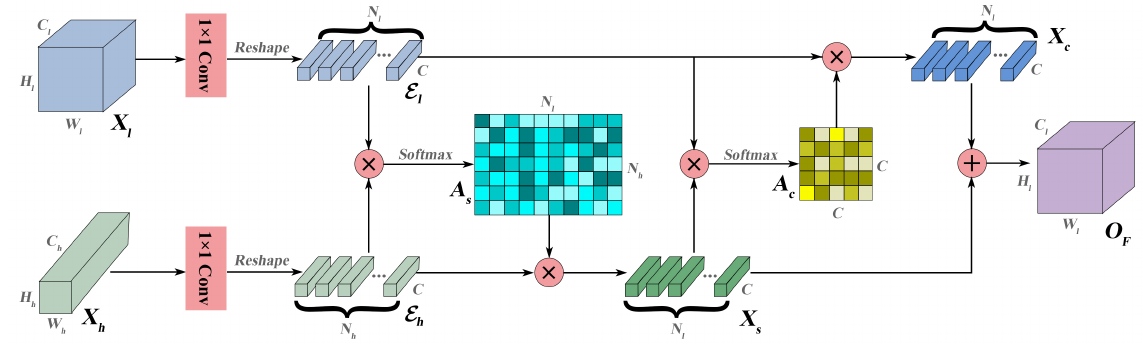
Figure 3. Attention Fusion Module. The spatial-fused feature X s is generated based on the spatial attention fusion map A s , i.e., the spatial similarity of the flattening low-level feature E l and the flattening high-level feature E h . The channel-fused feature X c is produced based on the channel fusion map A c , i.e., the channel similarity of E l and X c . Furthermore, the final output O F is obtained by the element-wise addition of X s and X c